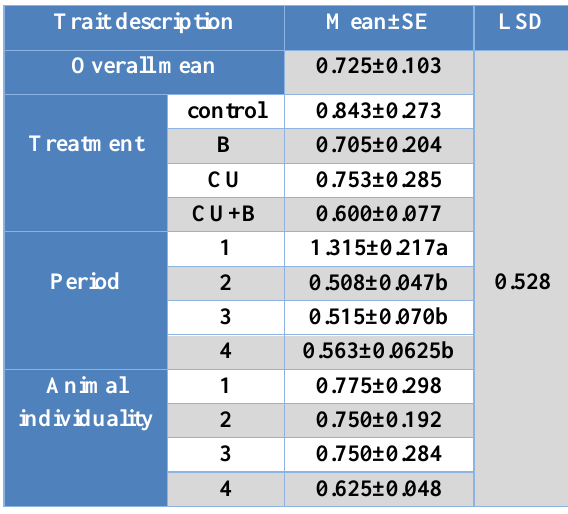
Table, 1: Effect of using Ocimum basilicum and/or Cuminum cyminum on rams body weight gain (Kg) during different period and Awassi ram